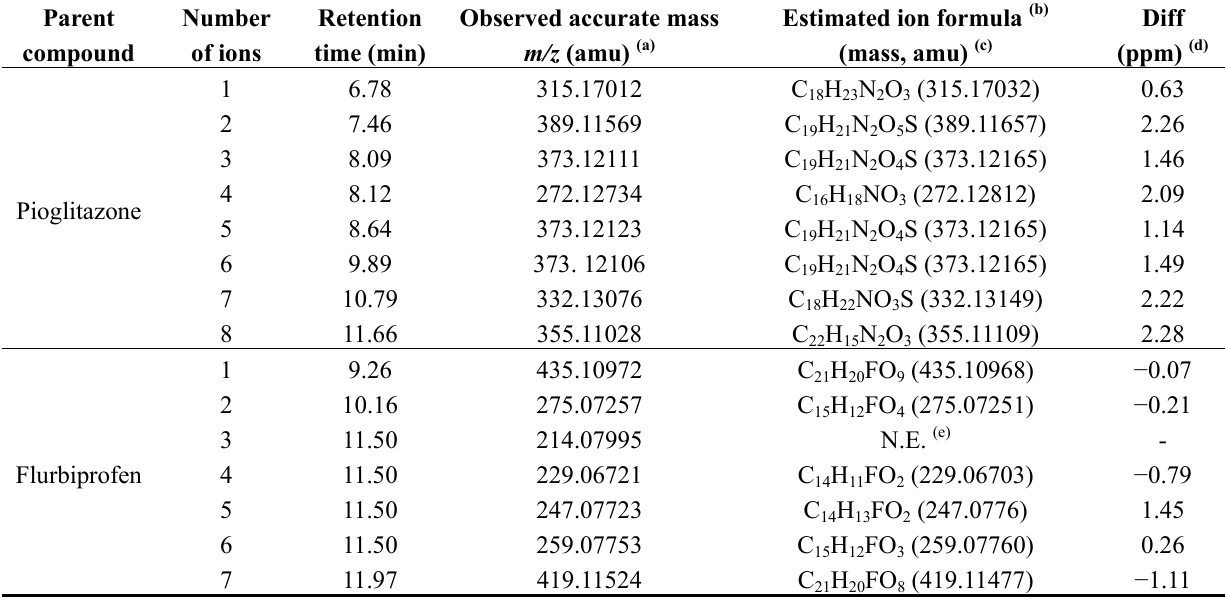
Table 2. Observed masses and estimated formula of ions detected by stable